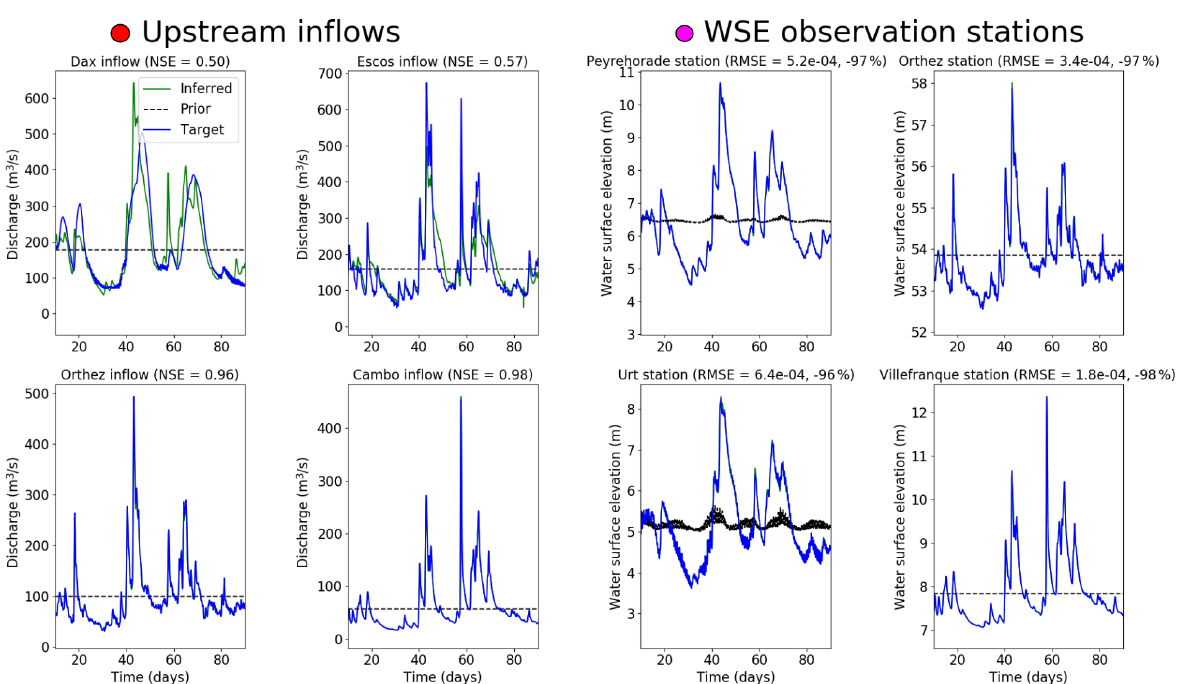
Figure 17. Upstream hydrograph inferences from four observation stations in a twin experiment setup. Left: upstream inflow hydrographs used to generate observations (blue); inferred hydrographs at 20 iterations (green); background hydrograph value given for iteration 0 (mean target inflow over assimilation window; dotted lines). NSE values are given for their informative value but are not used in the assimila- tion process. Right: target WS elevation (blue); WS elevation generated by the inferred hydrographs (green); WS elevation generated by the background hydrographs (dotted lines). Downstream tidal boundary influence is felt at the two stations furthest downstream (Urt and Peyrehorade). RMSE values given are used to calculate cost in the assimilation process (Sect.